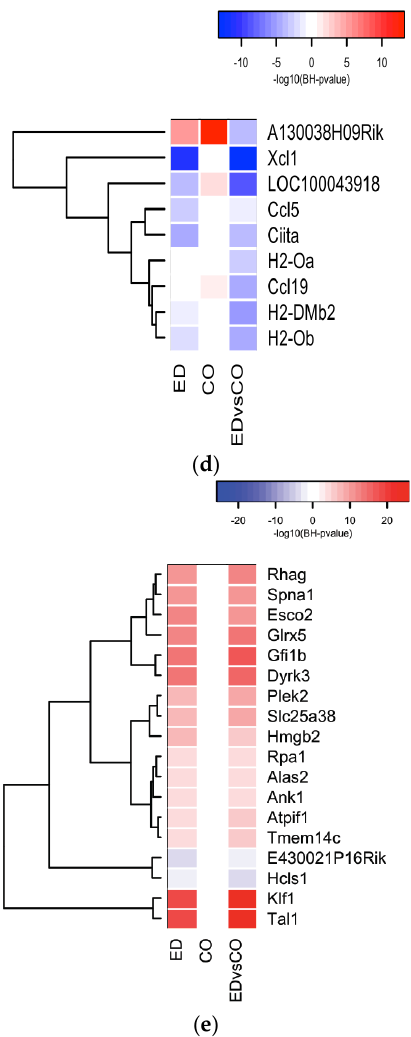
Figure 2. Heat map showing gene-expression patterns for any diet comparison i.e., HFD-ED vs. control; HFD-CO vs. control; HFD-ED vs. HFD-CO. for atleast one comparison BH- p value < 0.001 was considered significant. ( a ) Heat map showing group of genes regulated in NF- κ B regulation, in BP GO:0043123 positive regulation of I- κ B kinase/NF- κ B signaling, BP GO:0051092 positive regulation of NF- κ B transcription factor activity, and BP GO:0042346 positive regulation of NF- κ B import into nucleus; ( b ) Relative expression of different genes involved in modulation of NF- κ B in mouse spleen. Each gene is normalized against the house-keeping gene Ubiquitin ( Ubc ), and expression level shown as relative to the control diet; ( c ) Heat map showing groups of genes regulated in immune-related processes, including BP GO:0045087 innate immune response, BP GO:0002250